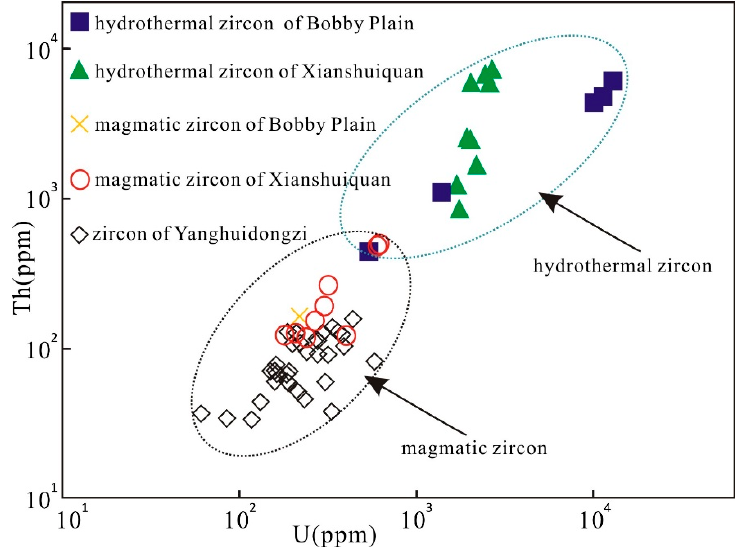
Figure 6. Th-U element covariation diagram of the Yanghuidongzi zircons.